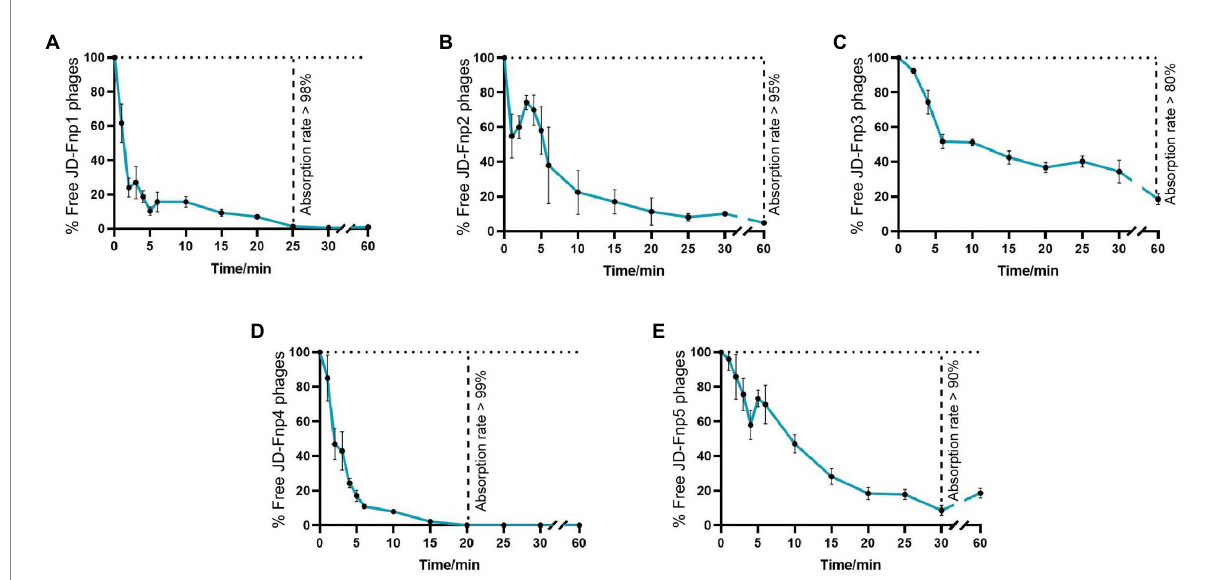
FIGURE 2 The adsorption profile of phages JD-Fnp1 ~ JD-Fnp5. (A) JD-Fnp1; (B) JD-Fnp2; (C) JD-Fnp3; (D) JD-Fnp4; (E) JD-Fnp5. The x-axis shows the incubation time of phages with host bacteria, and the y-axis shows the percentage of free phage particles. Data are from three times independent